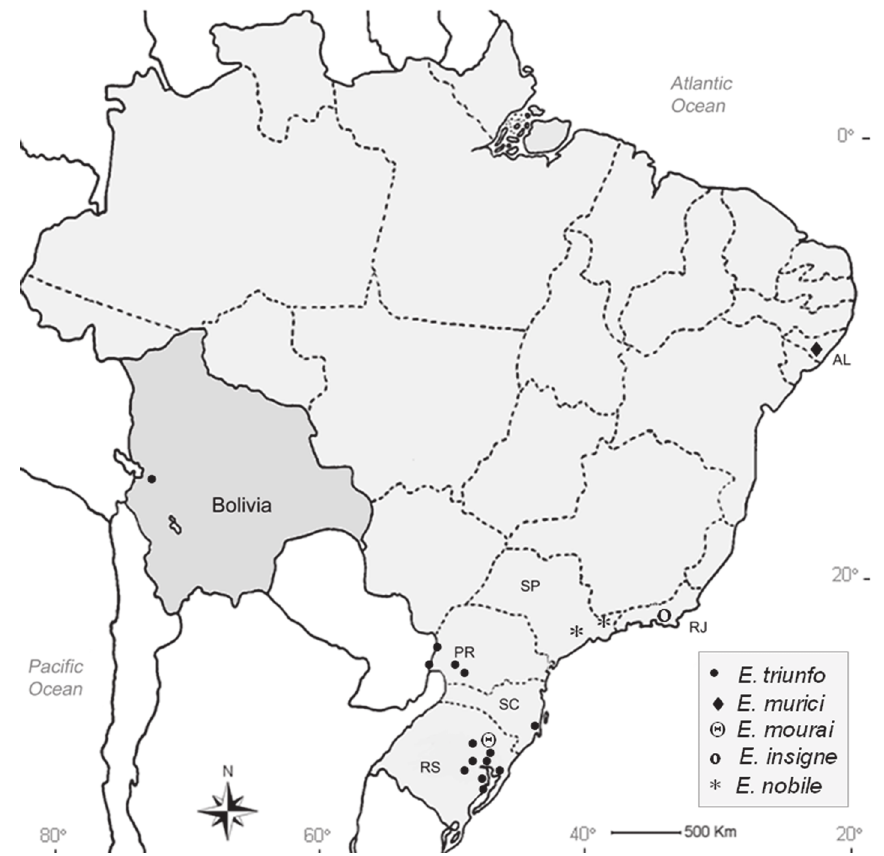
Figure 50. Map showing the distribution of Eurymorion mourai sp. nov. , E. murici sp. nov. , Eurymorion triunfo sp. nov . , E. insigne and E. nobile in Brazil and Bolivia. (AL) state of Alagoas, (PR) Paraná, (RJ) Rio de Janeiro, (RS) Rio Grande do Sul, (SC) Santa Catarina, (SP) São Paulo.